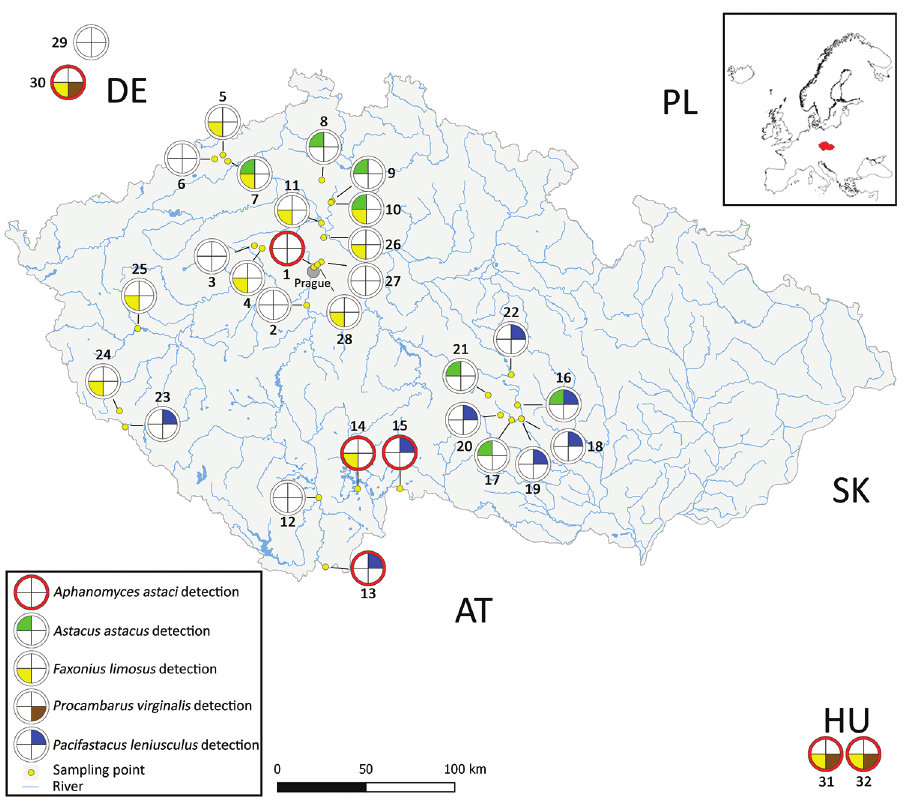
Figure 3. Map of Czechia with results of the eDNA screening at the sampling locations. Blue lines and areas represent the main water bodies, yellow dots represent each respective sampling point with numbers referring to the sampling sites in Table 2 and Suppl. material 1: Table S1. Pie charts: the red ring around the pie charts indicates unambiguous eDNA detection of A. astaci whereas a white ring represents non- detection. The green colour indicates detection of A. astacus , blue indicates detection of P. leniusculus , yellow represents detection of F. limosus and brown indicates presence of P. virginalis . The neighbouring countries are indicated by their two-letter ISO codes: AT, DE, HU, PL and SK stand for Austria, Ger- many, Hungary, Poland and